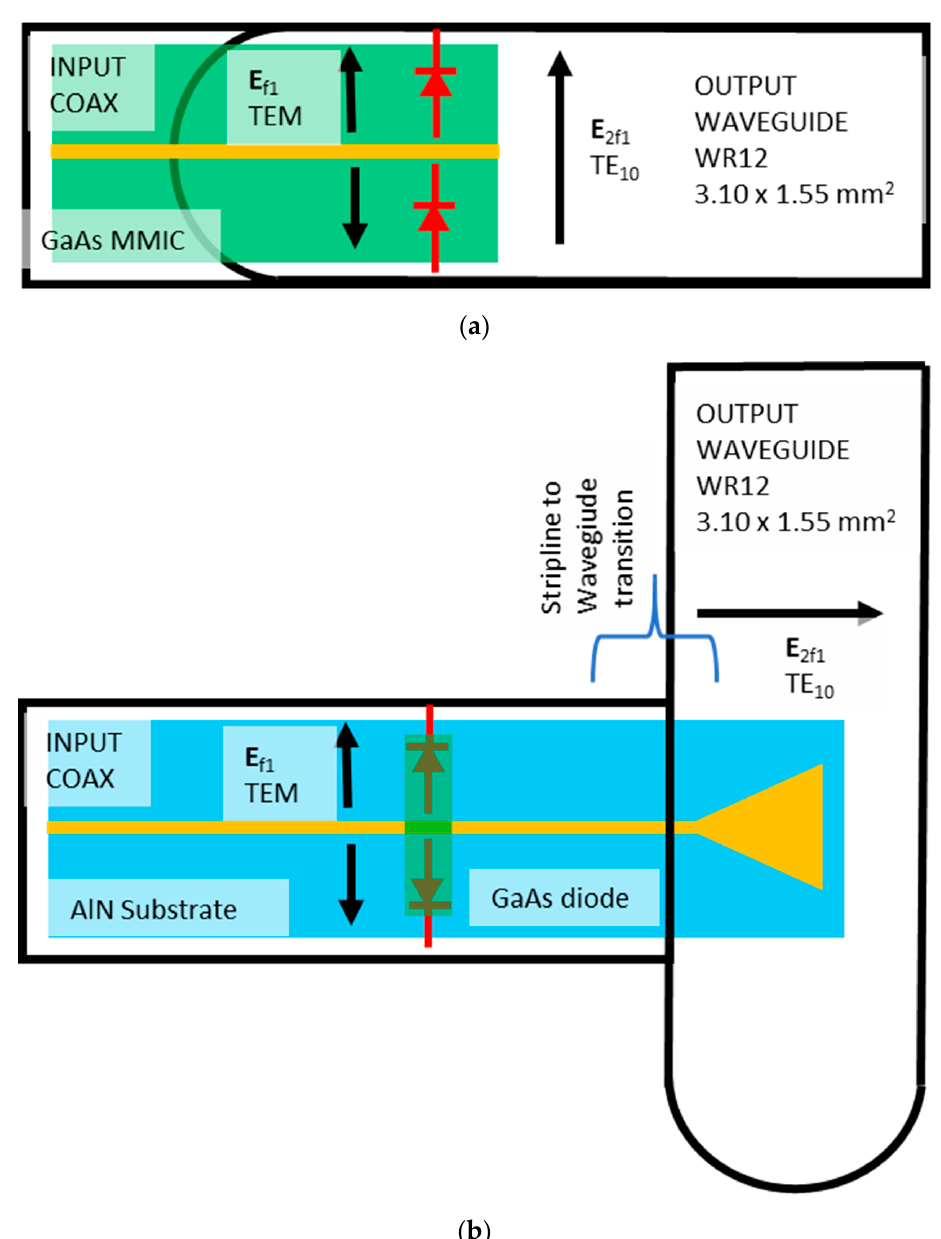
Figure 1. Simplified schematic figures showing fundamental, f, and second harmonic, 2f, field orientations for: ( a ) monolithic microwave integrated circuit (MMIC) doubler; ( b ) GaAs diode on an aluminium nitride (AlN) substrate hybrid.